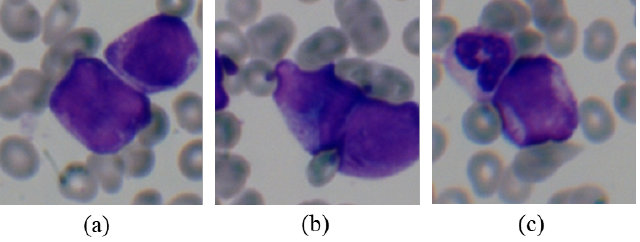
Figure 6. Three overlapping cell samples extracted from patient 3. The four cells in ( a , b ) are all promyelocytes, the upper one in ( c ) is neutrophil, and the other is the